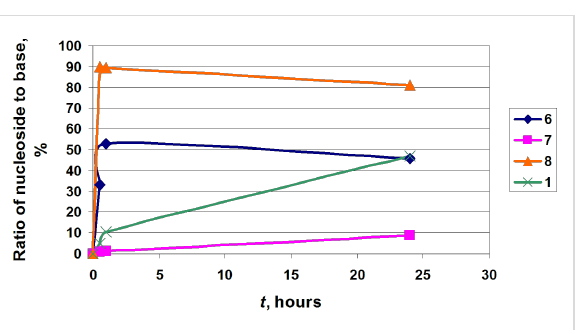
Figure 8: Progress of the formation of clofarabine ( 1 ), 9-( β -D-arabino- furanosyl)-2-chloroadenine ( 6 ), 9-( β -D-xylofuranosyl)-2-chloroadenine ( 7 ) and 2-cloroadenosine ( 8